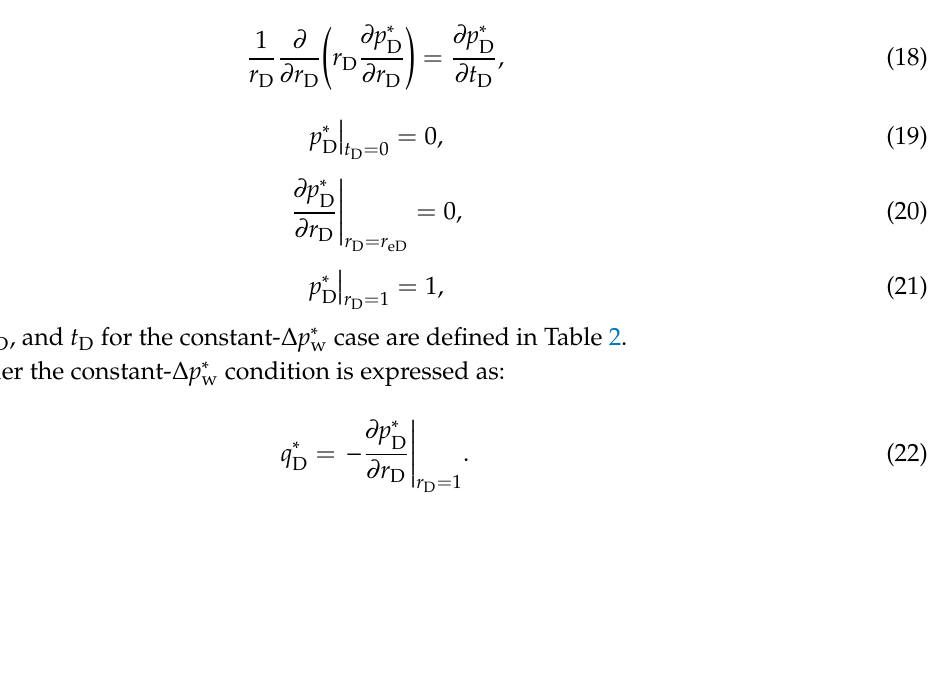
Figure 2. Comparison between the “1/ p wD vs. t cD ” curve for the CRP case and the “ q D vs. t cD ” curve for the CPP case.